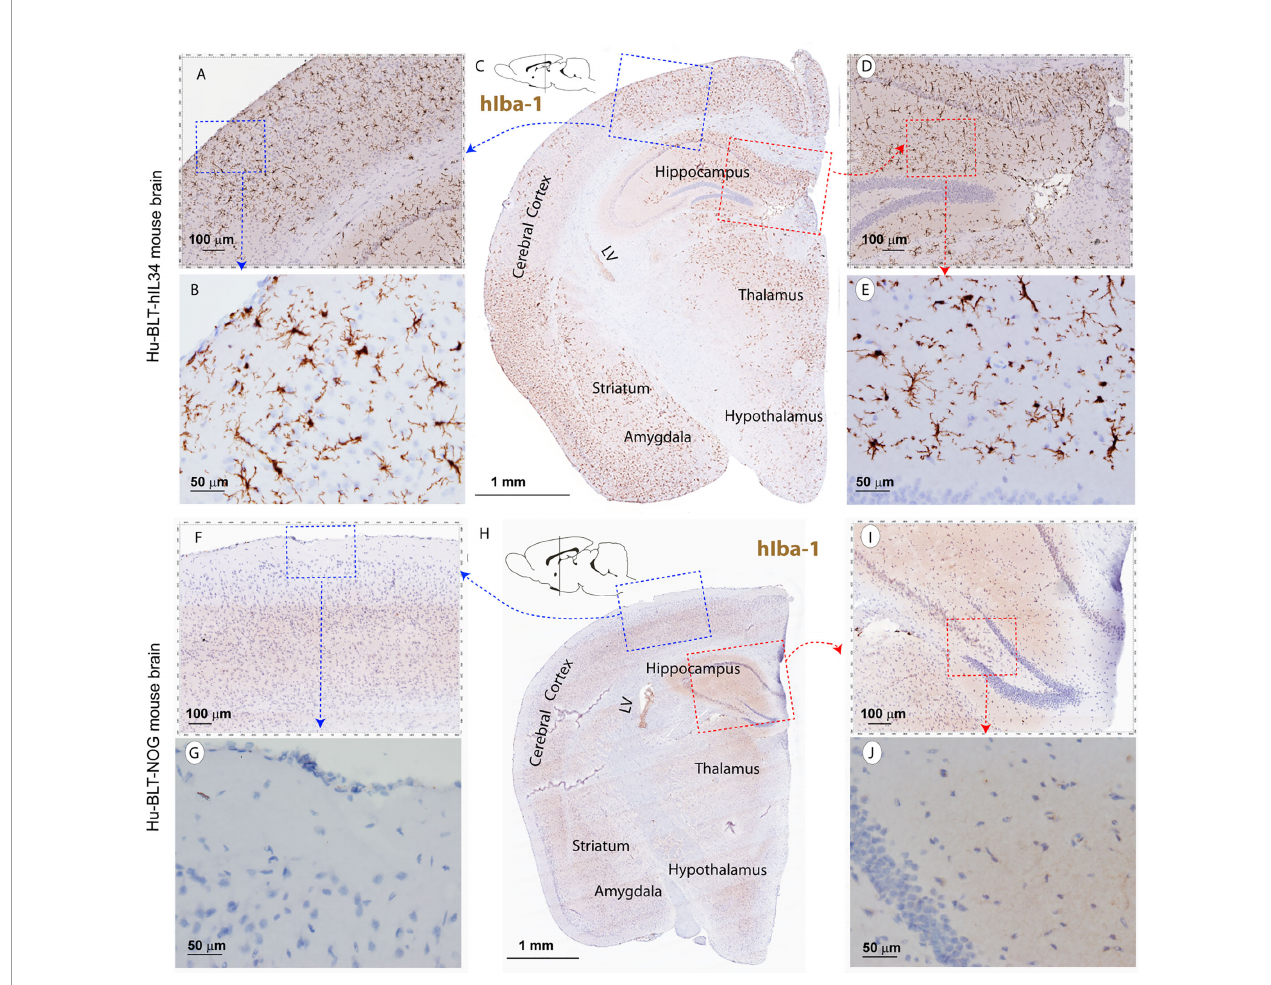
FIGURE 2 | The hIba-1+ myeloid cell reconstitutions in the brain tissues of hu-BLT-hIL-34 and hu-BLT mice. The upper panel (A – E) shows a representative whole brain tissue section from the third coronal brain slice of a hu-BLT-hIL34 mouse (#1703) that was stained immunohistochemically for hIba-1+ (brown) and counterstained with hematoxylin. LV stands for lateral ventricle. The blue and red boxed regions in the Figure C were highlighted at a higher magni fi cation (A, D) . In turn, the blue and red boxed regions of the (A, B) were further highlighted (B, E) . The hIba-1+ cells are morphologically rami fi ed and mainly distributed in brain parenchyma. The lower panel (F – J) shows a representative whole brain tissue section (H) of a hu-BLT mouse (#1717) that was stained immunohistochemically for hIba-1+ cells (brown). The blue and red boxed regions in the Figure H was highlighted at a higher magni fi cation (F, I) . In turn, the blue and red boxed regions of the (F, I) were further highlighted (G, J) . There were no detectable parenchymal hIba-1+